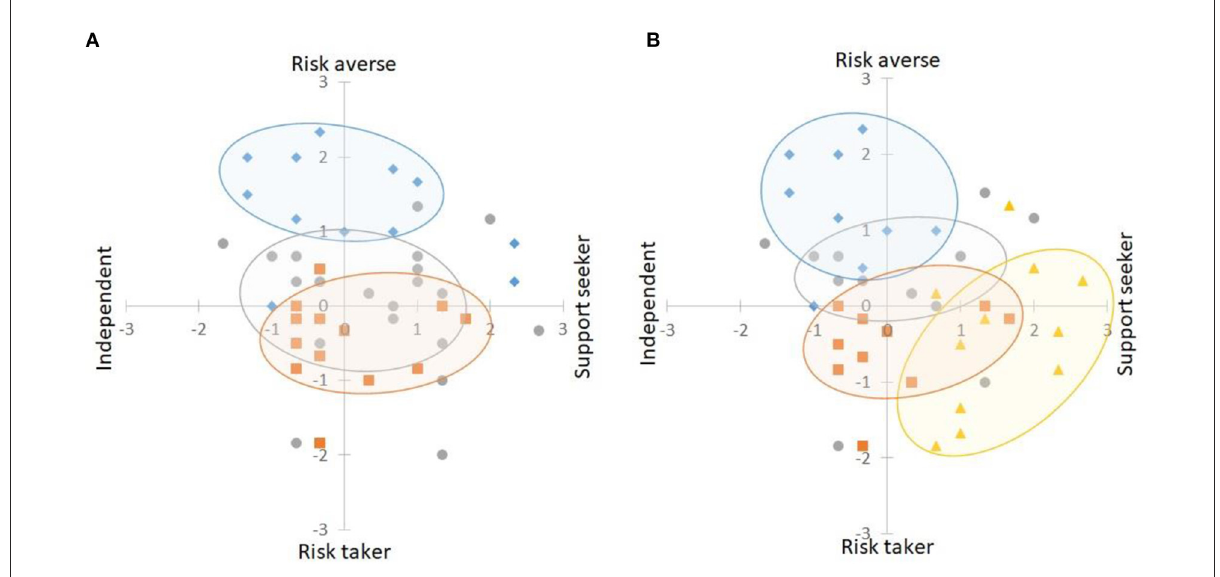
FIGURE1 Q maps of (A) three-factor and (B) four-factor solutions. Gray circles, red squares, blue diamonds and yellow triangles represent factors 1, 2, 3, and 4 (for four-factor solution), respectively. Bubbles with the same colors reflect the clustering of the corresponding loaders regarding the support and risk thematic axes.